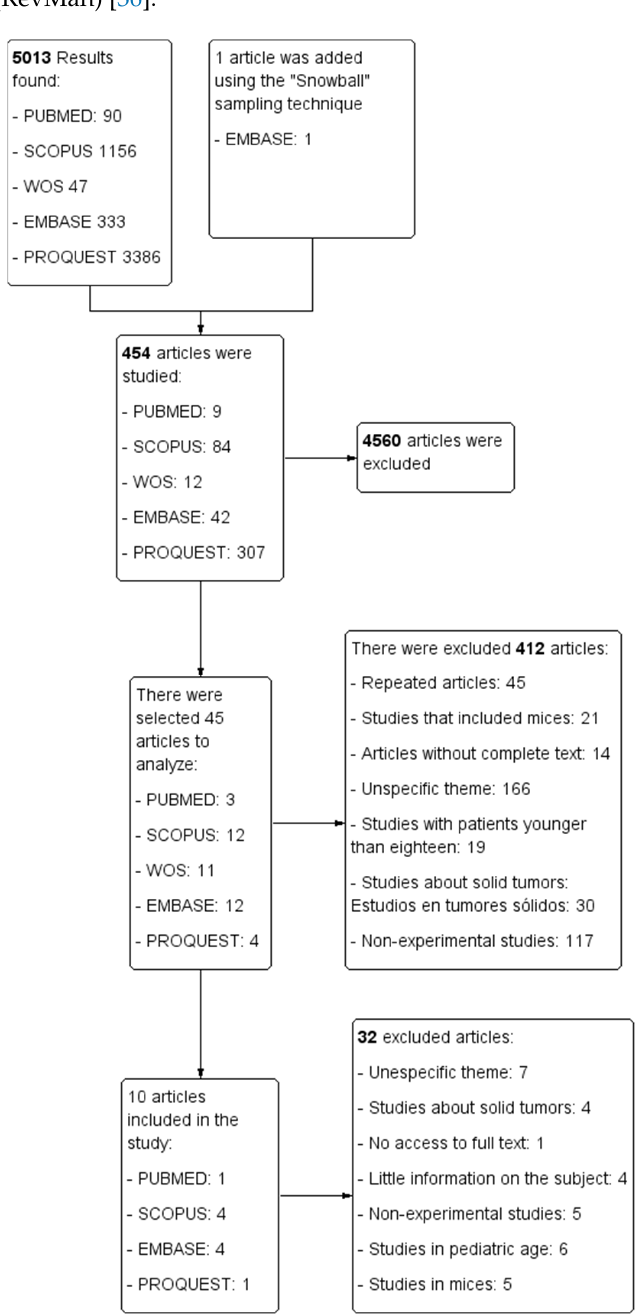
Figure 2. PRISMA flowchart.